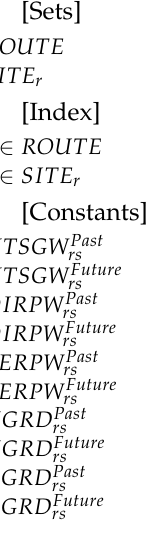
After acquiring the aforementioned constants, the error in the weather conditions at each site is calculated from the square of the error between the past and future constants. Equation (1) shows that the errors of all the sites can be summed to yield the error in the weather conditions for the route of interest. This process is applied to all the routes extracted in